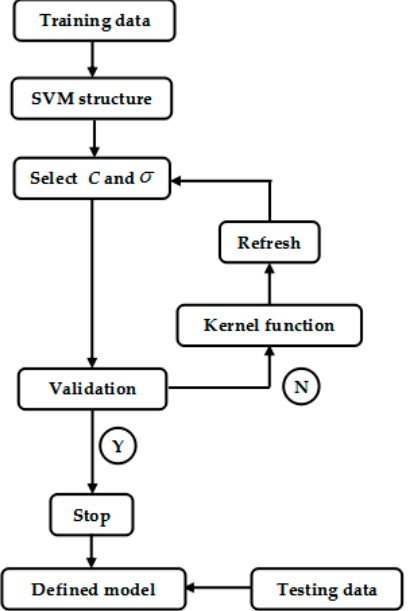
Figure 5. Flowchart for best parameters selection for the SVM (support vector machine) model.